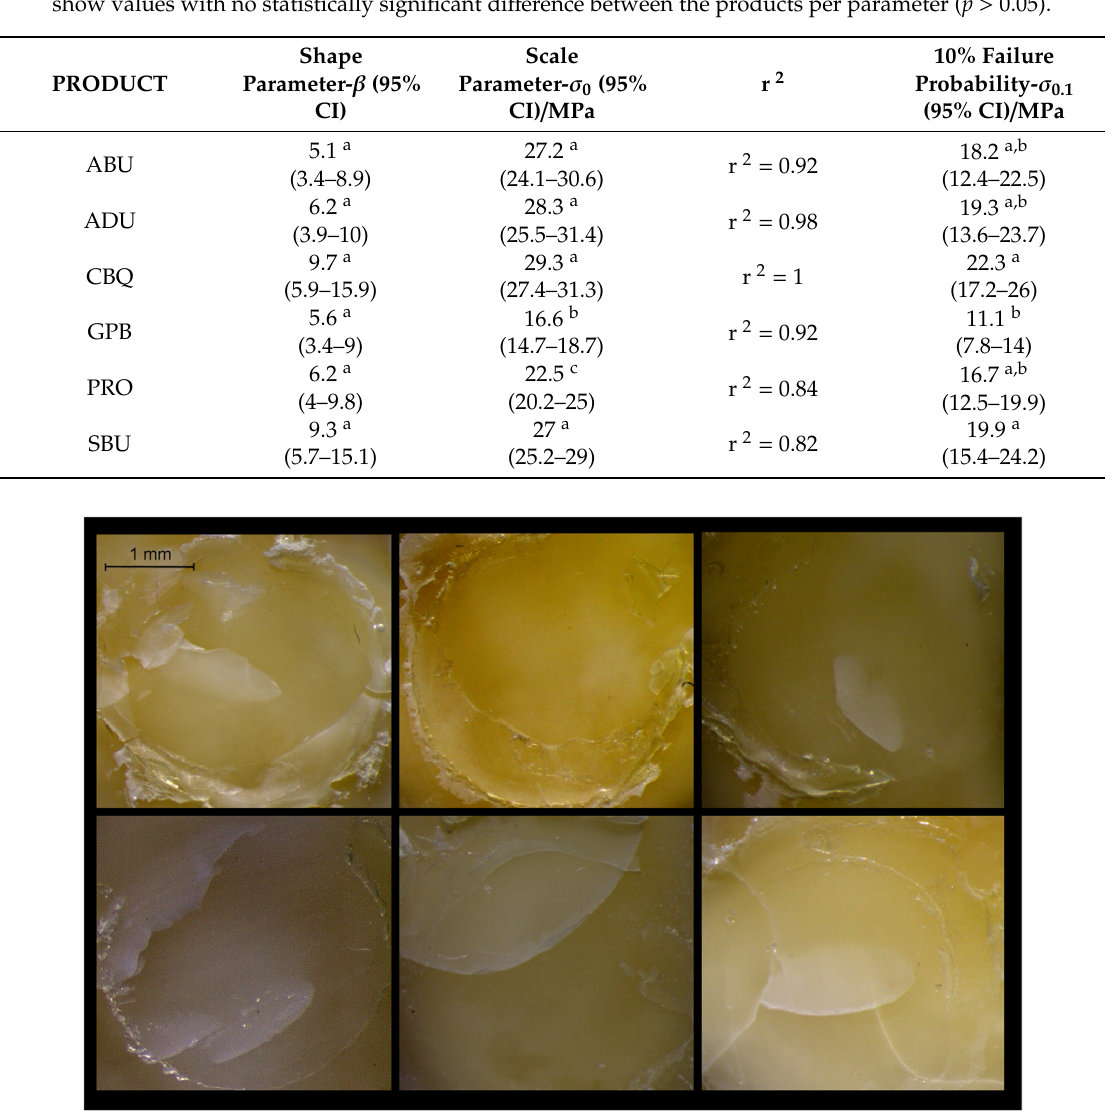
Figure 5. Representative stereomicroscopic images of dentin surfaces after debonding demonstrating type III failures (adhesive and resin cohesive) with various extent of dentin surface coverage (10× magnification, bar = 1 mm).